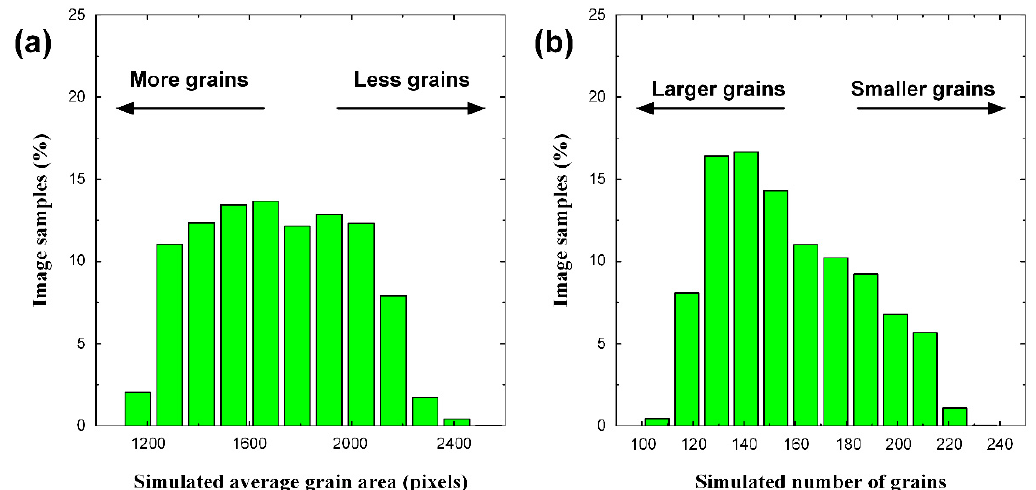
Figure 7. Distribution of image samples used for CNN training and test in terms of ( a ) average grain area and ( b ) number of grains. Note that the distribution for average grain area is relatively uniform, while the distribution for number of grains shows imbalance.